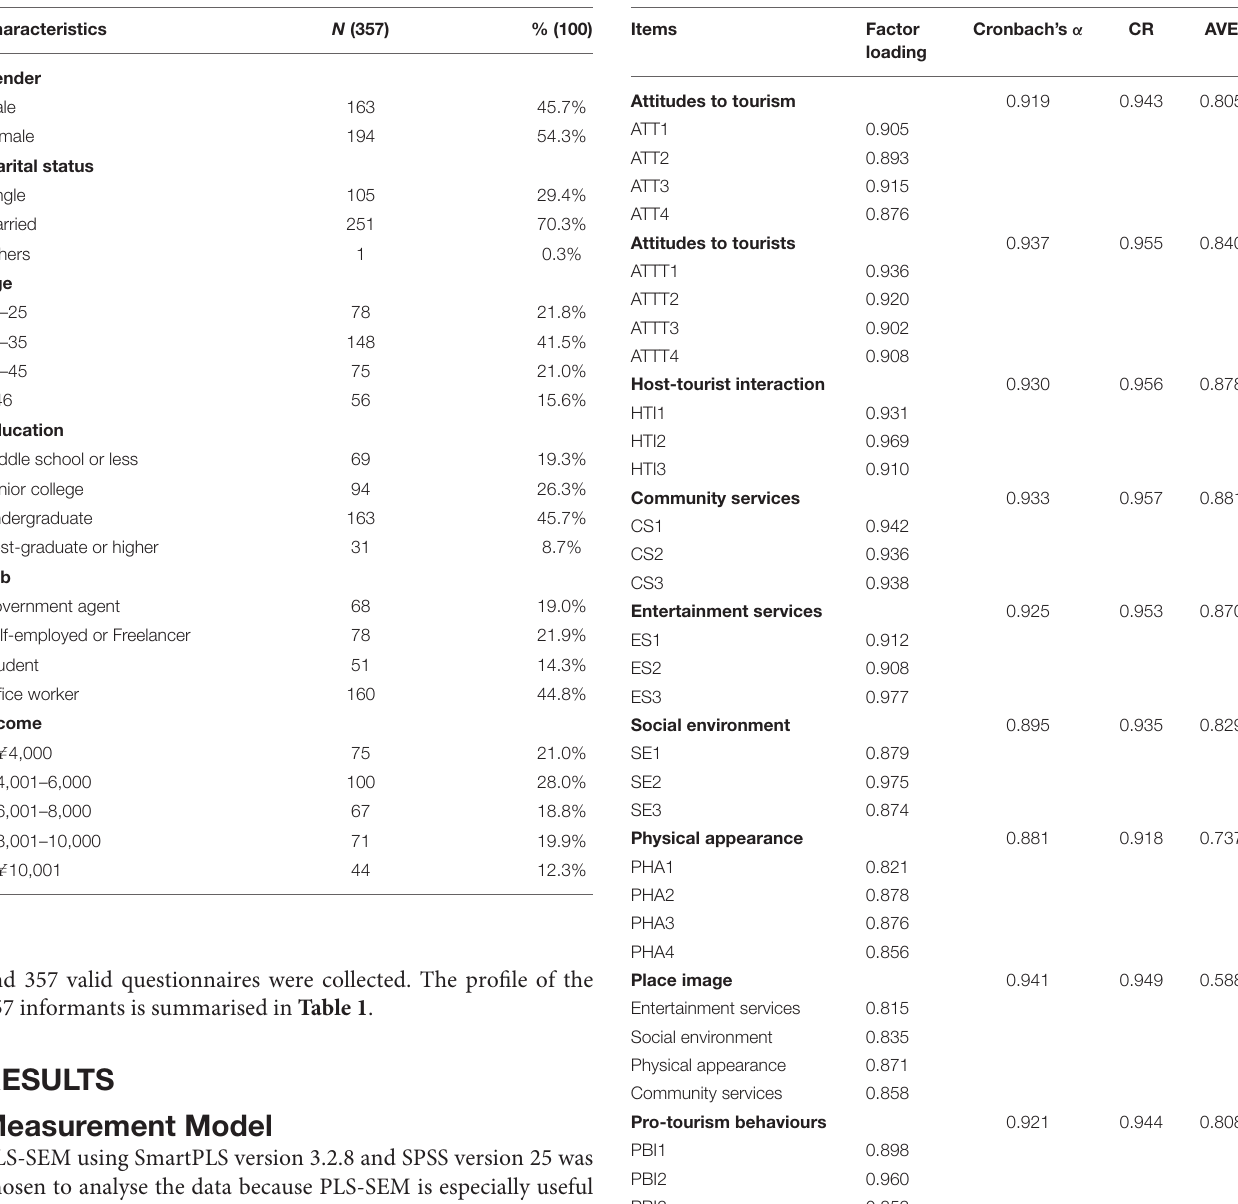
TABLE 1 | Socio-demographic information of respondents. TABLE 2 | Results of confirmatory factor analysis.